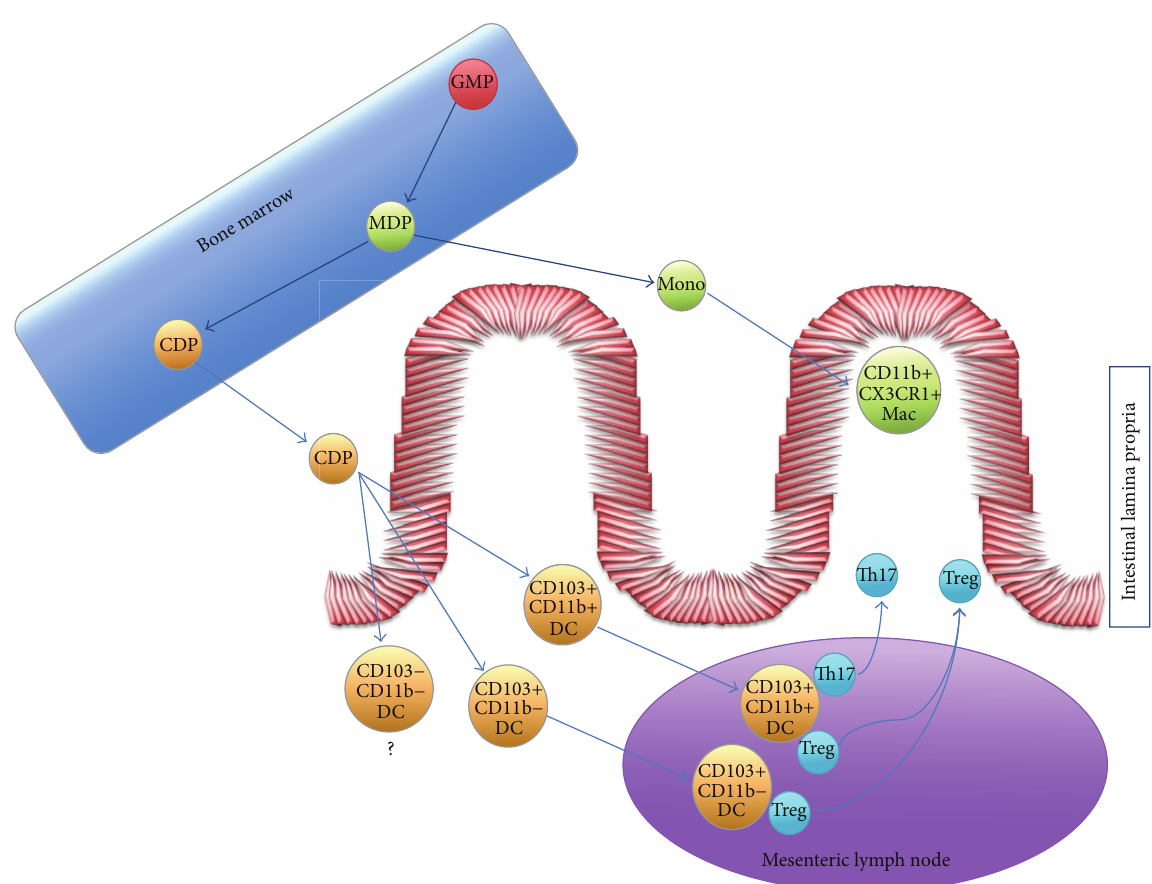
Figure 1: Intestinal mucosal dendritic cell and macrophage development and function. Bone marrow resident Granulocyte Macrophage Progenitors (GMP) give rise to Macrophage DC Precursors (MDP). In turn, CDP give rise to peripheral blood monocytes (Mono) and Common DC Progenitors (CDP). Monocytes will migrate to the lamina propria differentiating into CD11b+CX3CR1+ macrophages that directly sample antigens from the intestinal lumen. On the other hand, CDP will give rise to three subpopulations of intestinal lamina propria DCs: CD11b+CD103+, CD11b − CD103+, and CD11b − CD103 − . The former two subsets are responsible for sampling antigen and priming na¨ıve T cells into regulatory T cells (Treg) or IL17-producing T cells